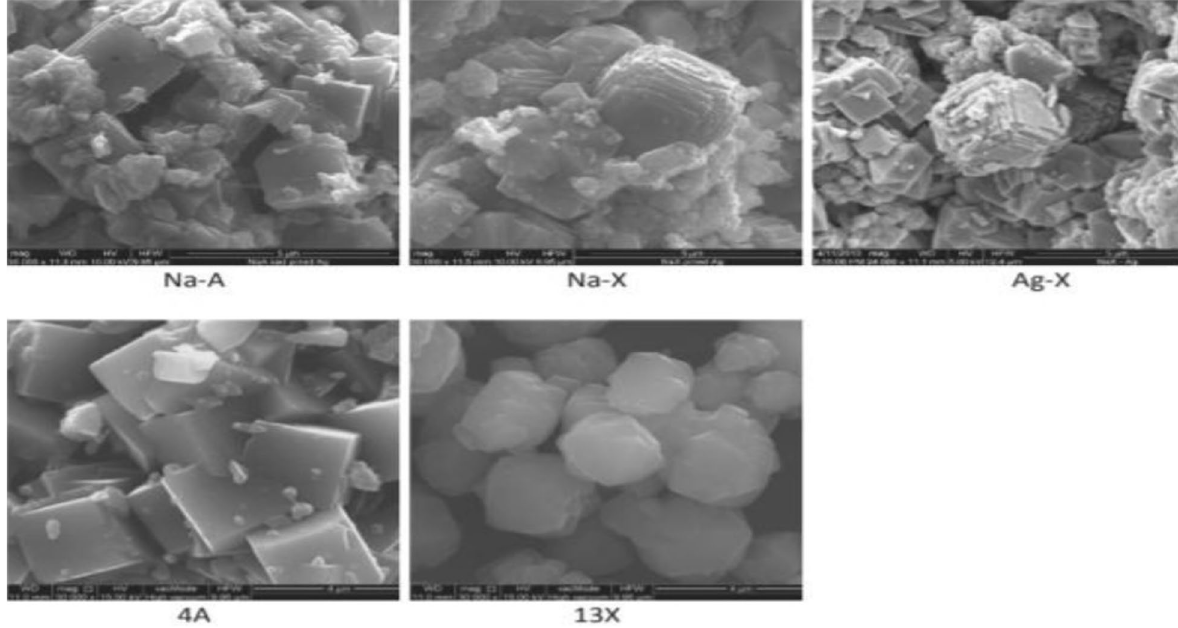
Fig. 33 Morphology of tested fly ash derived zeolite materials (type X and A) and commercial zeolite (4A and 13X) (Czarna et al.